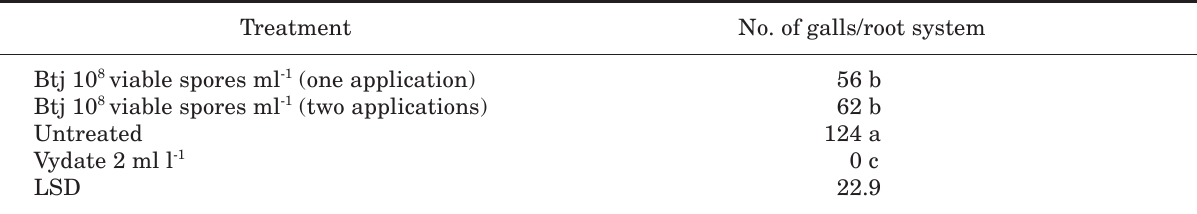
Table 2. Effect of the number of applications of Bacillus thuringiensis jordanica (H71) on Meloidogyne javanica and its damage to tomato in a glasshouse pot experiment